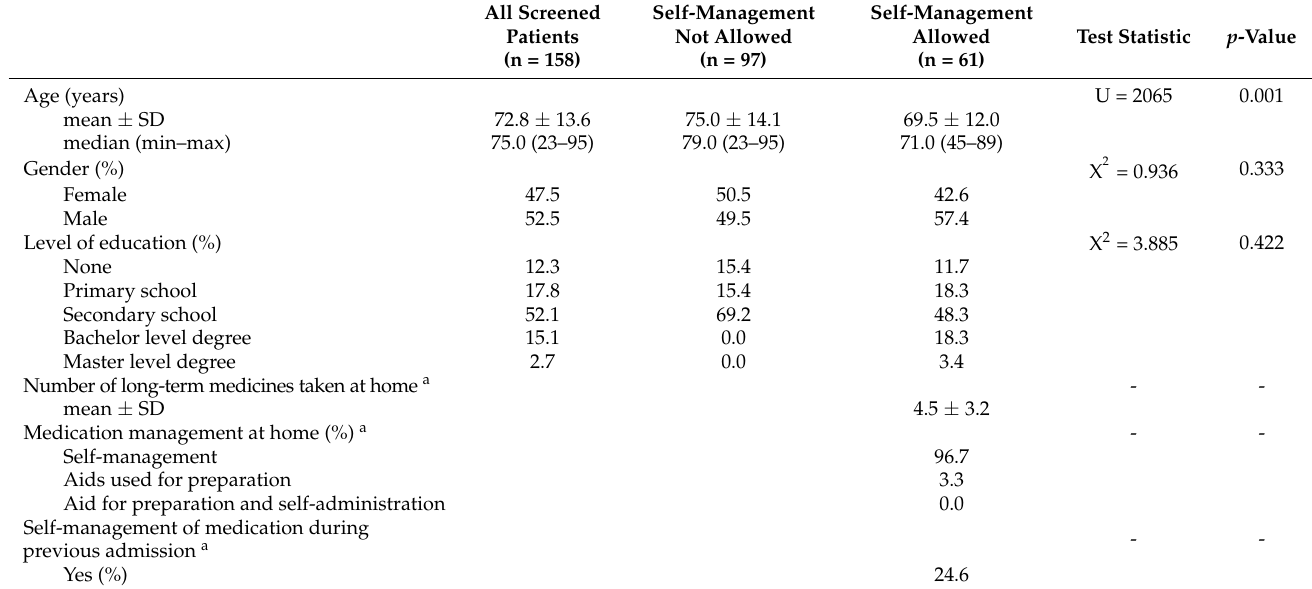
Table 2. Patient demographic data and medication management characteristics.